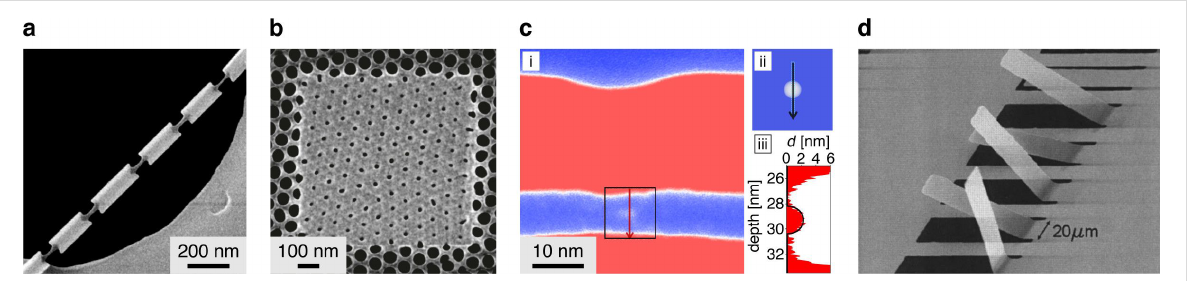
Figure 4: Examples of restructuring using localized helium and neon ion irradiation. (a) Localized thinning of a GaAs nanowire by site-selective helium ion irradiation at low dose: The proposed mechanism is mass transport by surface diffusion. Adapted from [97]. Copyright © 2017 WILEY-VCH Verlag GmbH & Co. KGaA, Weinheim. Used with permission from Aramesh, M., Ion-Beam Sculpting of Nanowires, physica status solidi (RRL)-Rapid Research Letters, John Wiley and Sons. (b) Related pore shrinking of nanoporous amorphous aluminum oxide by helium ion irradiation. Adapted from